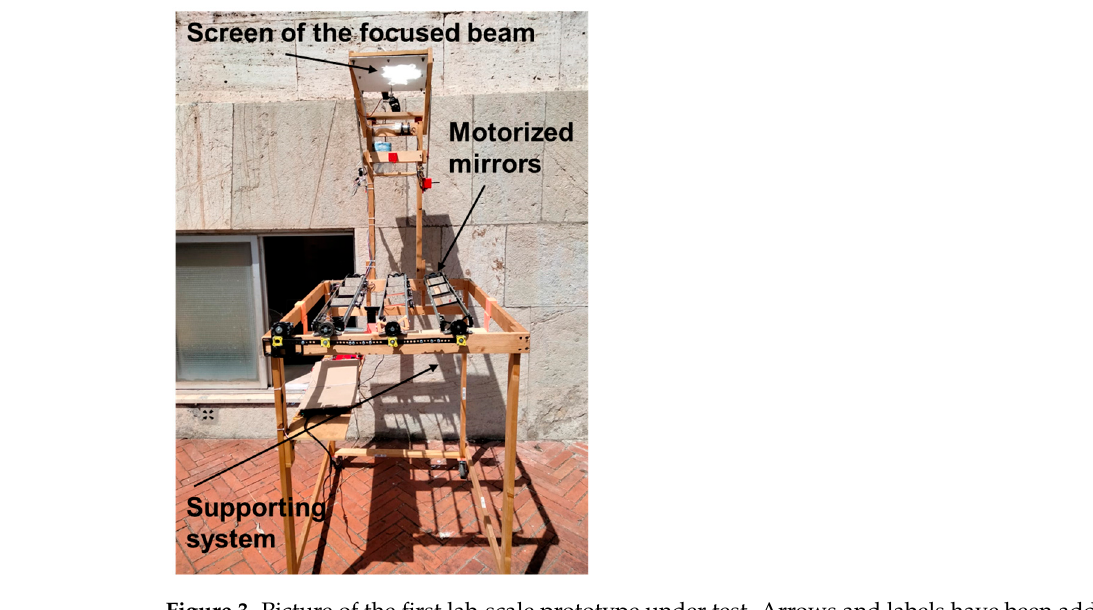
Figure 3. Picture of the first lab-scale prototype under test. Arrows and labels have been added to better identify the main elements of the concentrator.